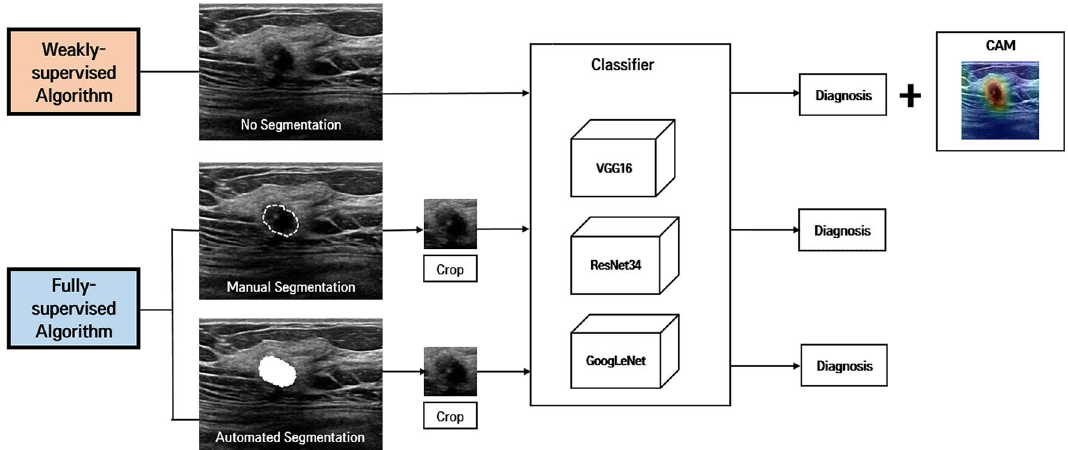
Figure 2. Overview of weakly-supervised and fully-supervised deep learning (DL) algorithms for breast mass classification and localization. The weakly-supervised DL algorithm does not require image annotation of region of interest (ROI) of the lesion, whereas the fully-supervised DL algorithm requires tumor segmentation (manual or automated) and cropping for ROI before being put in the classifiers. For the weakly-supervised DL algorithm, a class activation map (CAM) is generated to visualize the region detected by this algorithm using a global average pooling layer (GAP) that is added to the final convolutional